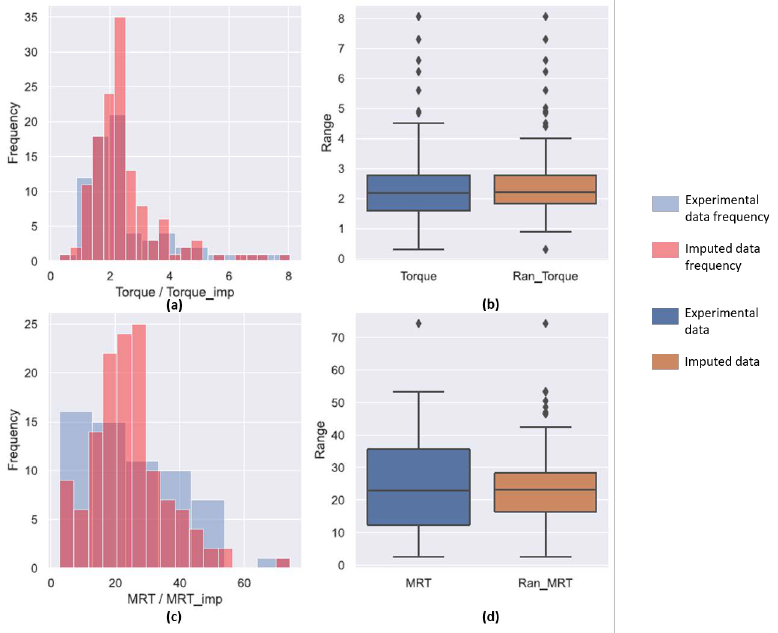
Figure 2. ( a , c ) compare the frequency of occurrence of each value of torque and MRT, respectively. The blue bar in the plot represent the experimental values while the red bars represent the values predicted by the stochastic regression model. ( b , d ) are box plots comparing the median values as well as the range of experiments to the median and range obtained from the stochastic regression model for the torque and MRT, respectively. A good stochastic regression model is one which can mimic the range of the experiments. The diamond points represent points that lie beyond the statitical